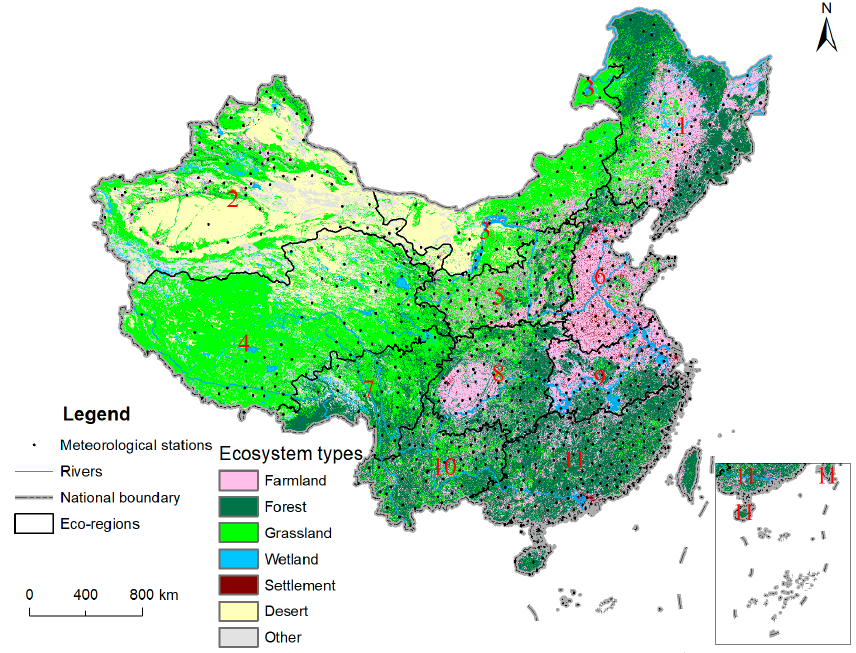
Figure 1. The distributions of ecoregions, meteorological stations and ecosystem types in